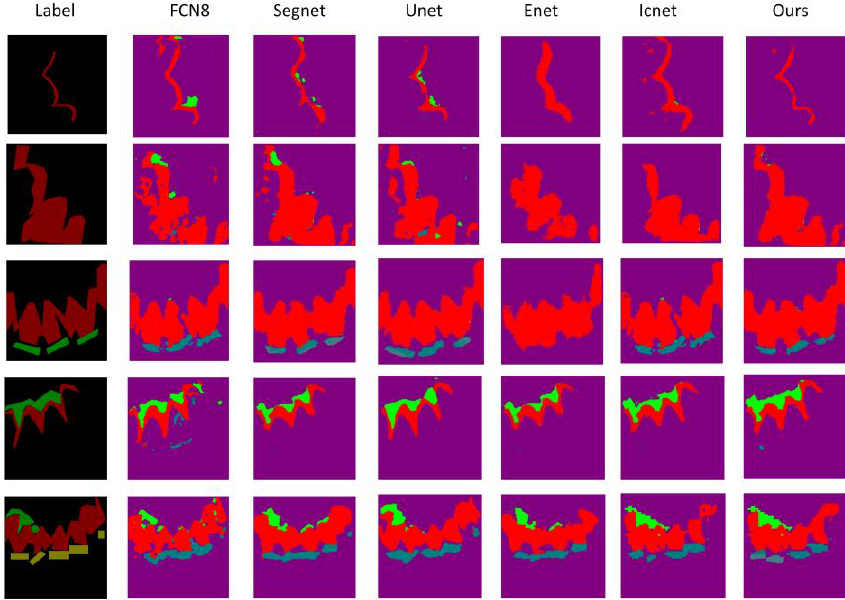
Figure 11. Visual comparison chart of segmentation results of different algorithms.